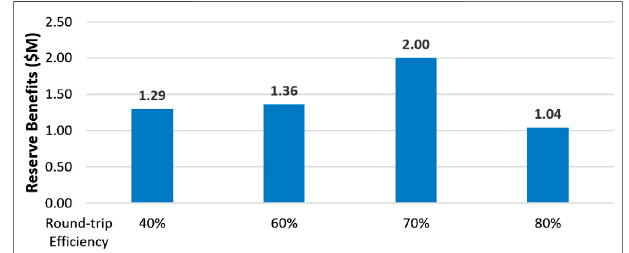
Figure 18 . Overall, as the energy storage round-trip ef fi ciency increases, the entire system CO 2 emission will reduce. These